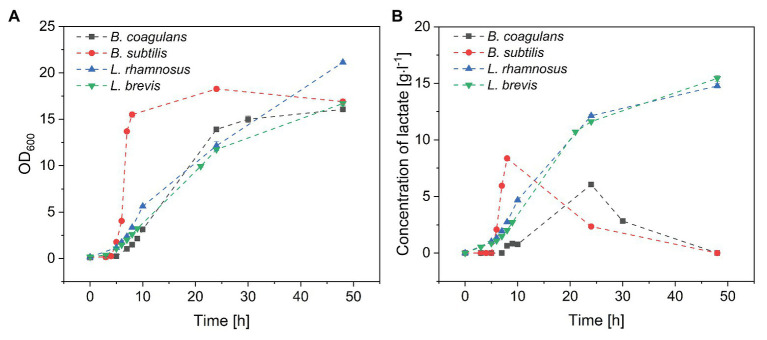
Batch fermentation of probiotic bacteria in medium containing crude fructo-oligosaccharides (FOS). (A) Growth curve and (B) lactate concentration during the fermentation. T = 40°C, pH = 6.8, and agitation = 0.5 vvm. Values are means ± error (n = 2).